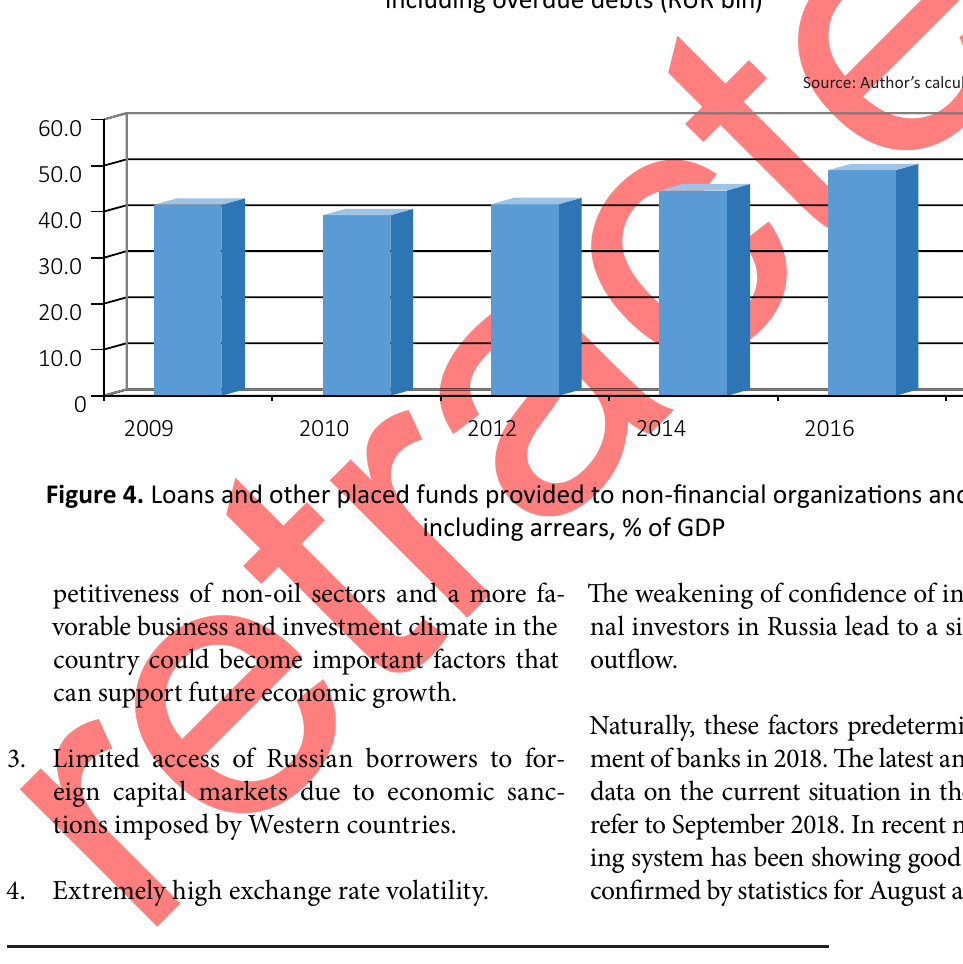
Figure 3. Loans and other placed funds provided to non-financial organizations and individuals, including overdue debts (RUR bln)